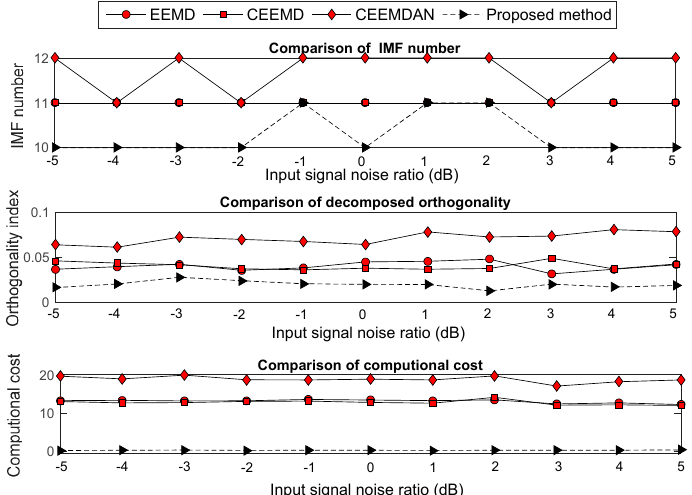
Figure 9. Comparison of the decomposition effect for the ‘heavy sine wave’ signal.